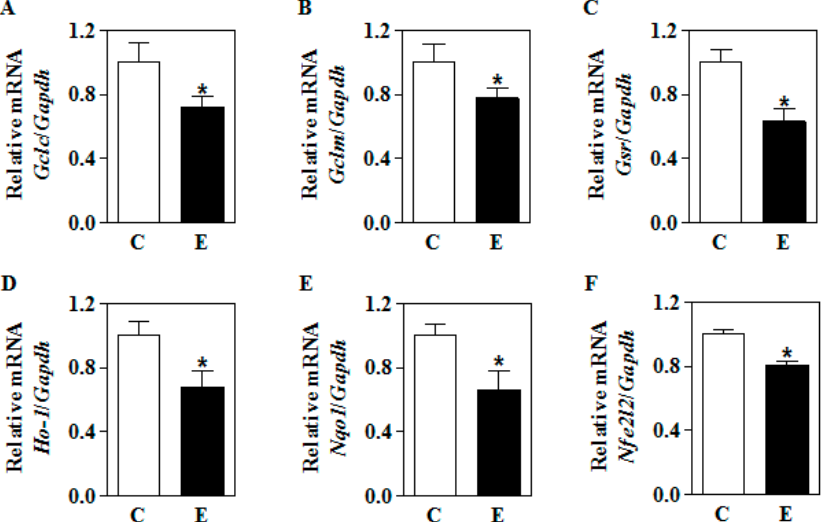
Figure 4. Effect of in utero alcohol exposure on the mRNA expression of Nfe2l2 and NRF2 target genes’ in the placenta. Pregnant SD rats were exposed to air (C) or IEV (E) for the periods indicated in Figure 1 and real-time qRT-PCR analysis for NRF2 target genes’ was performed. ( A ) The fold change mRNA expression of Gclc ; ( B ) Gclm ; ( C ) Gsr ; ( D ) Ho-1 ; ( E ) Nqo1 ; and ( F ) Nfe2l2 was determined by normalizing with the expression of a housekeeping gene, Gapdh . A total of 12 samples with 4 each from 3 different litters were examined. Values represent the mean ± SEM. * p < 0.05 was considered significant versus ethanol.